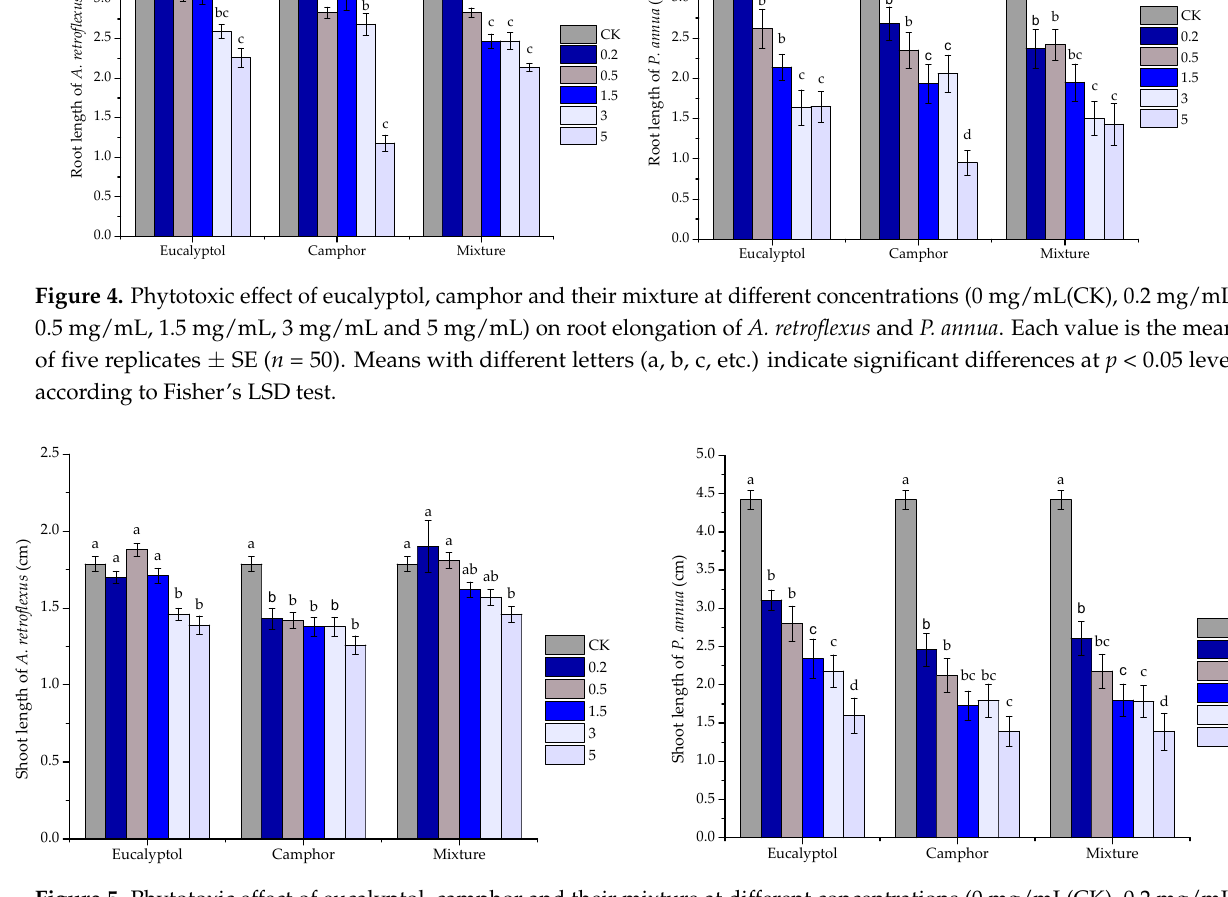
Figure 5. Phytotoxic effect of eucalyptol, camphor and their mixture at different concentrations (0 mg/mL(CK), 0.2 mg/mL, 0.5 mg/mL, 1.5 mg/mL, 3 mg/mL and 5 mg/mL) on shoot development of A. retroflexus and P. annua . Each value is the mean of five replicates ± SE ( n = 50). Means with different letters (a, b, c, etc.) indicate significant differences at p < 0.05 level according to Fisher’s LSD test.